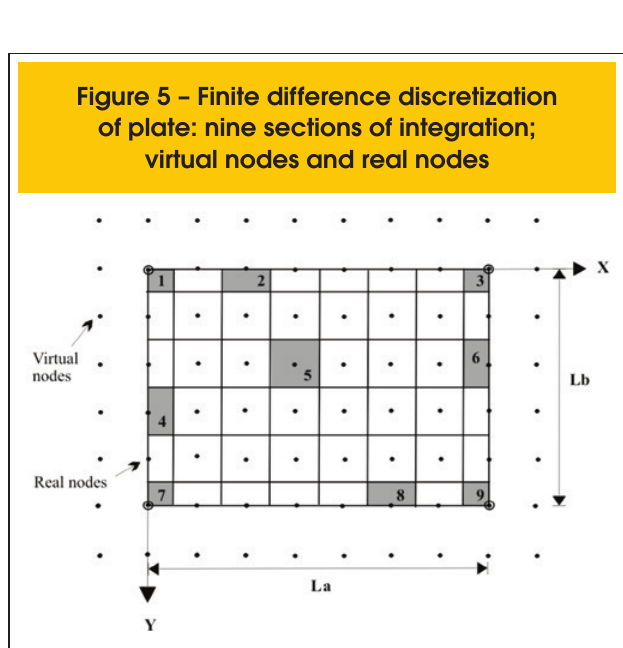
Figura 4 – Function f (x) used to represent the derivative of displacement